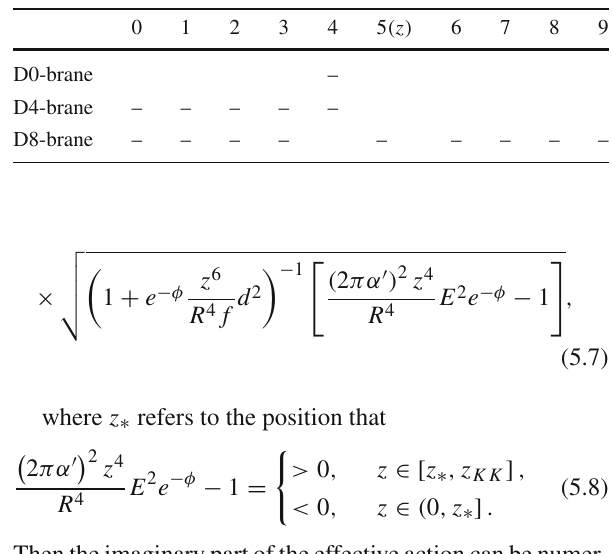
Table 2 The configuration of the D-branes in the D0–D4